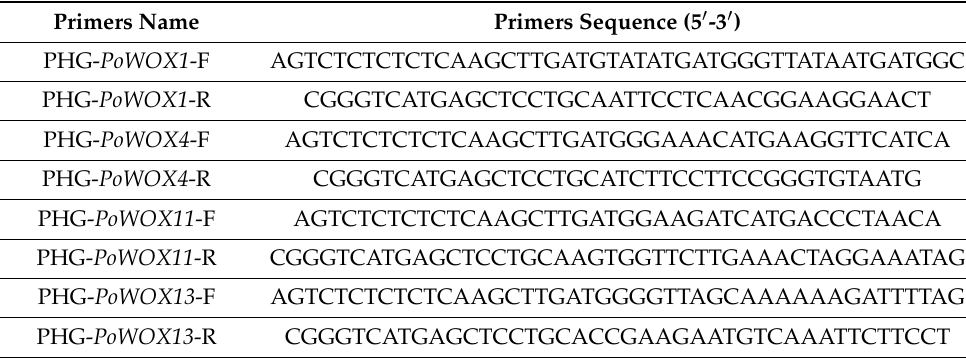
Table 3. Primer sequences of plant expression vector 35S::PoWOX-GFP